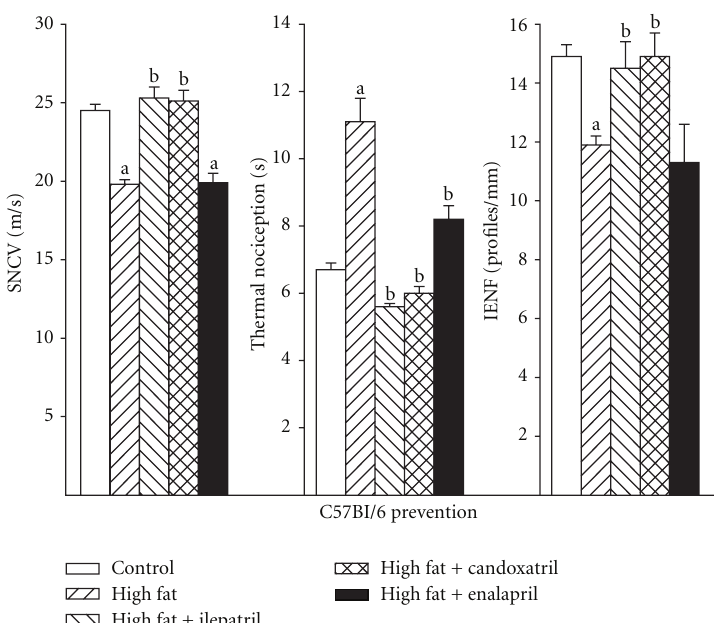
Figure 5: Sensory nerve conduction velocity, thermal nociception, and intraepidermal nerve fiber profiles for C57Bl/6J mice fed a normal or high-fat-containing diet with or without ilepatril, candoxatril, or enalapril for 12 weeks (prevention protocol). Control (open bar), high fat (right hatch bar), high fat + ilepatril (left hatch bar), high fat + candoxatril (cross hatch bar), and high fat + enalapril (closed bar). Data are the mean ± SEM. The number of mice in each group was the same as shown in Table 1. a, P < 0 . 05 versus control; b, P < 0 . 05 versus high-fat-fed mice.